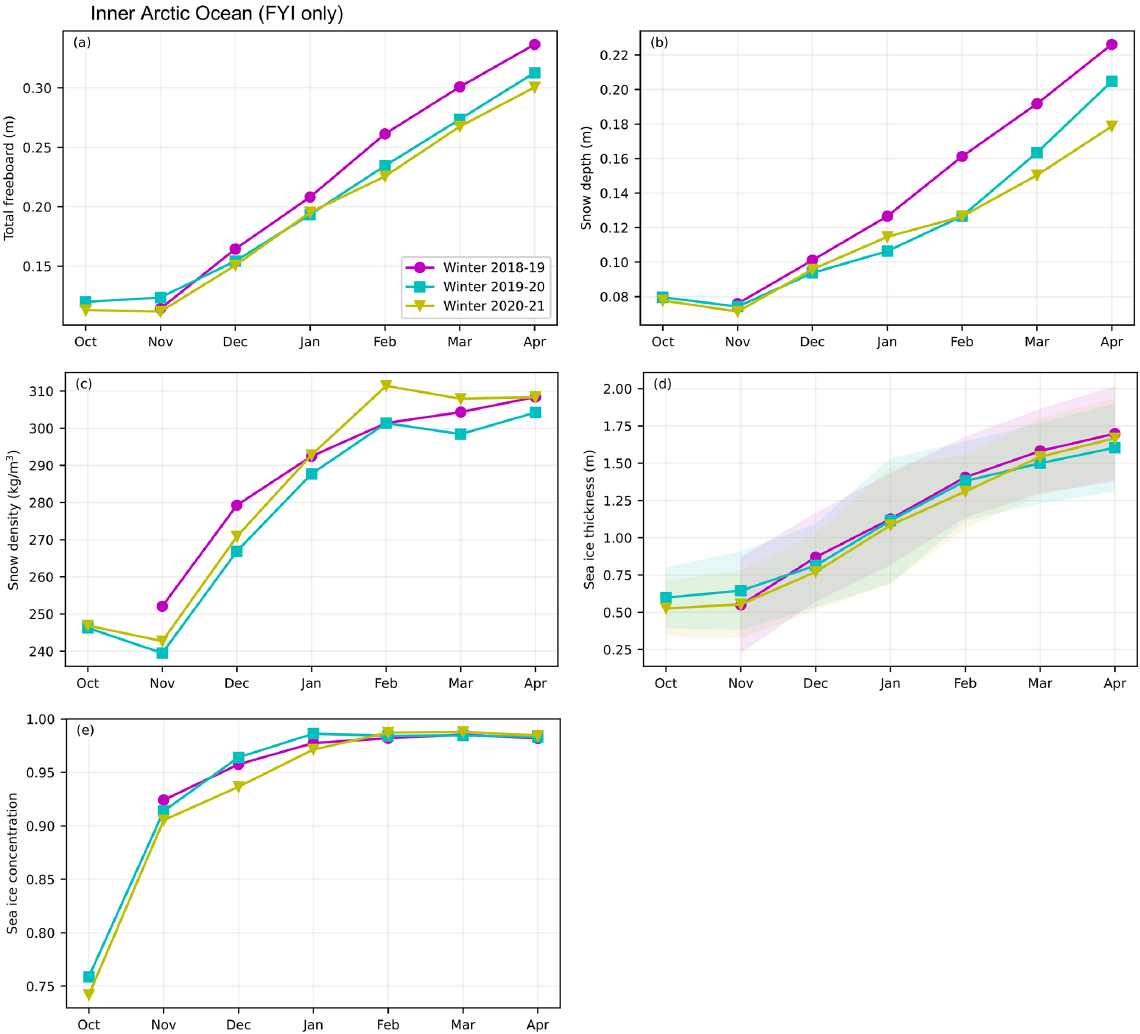
Figure 15. As in Fig. 12 but for monthly means of grid cells identified as first-year ice (FYI) only based on the OSI SAF ice type product. This figure starts in October due to the lack of reliable FYI coverage information in